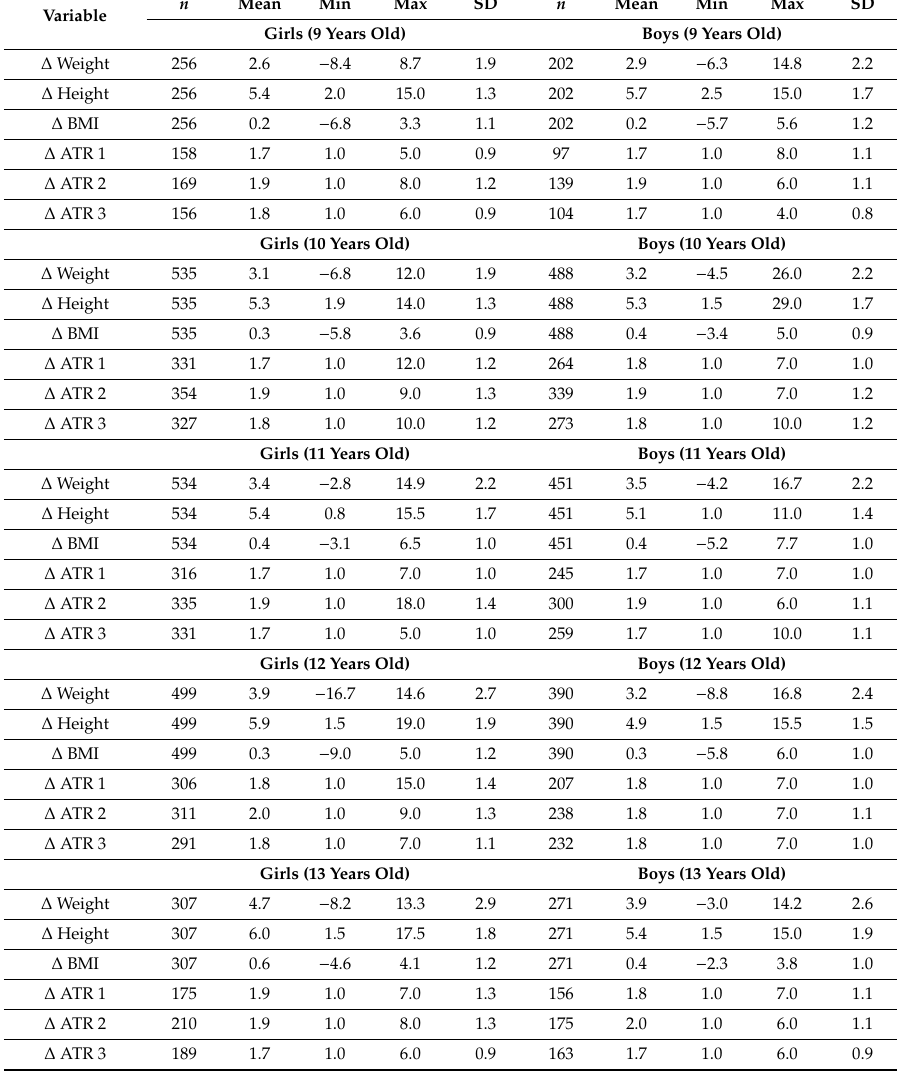
Table 1. Basic characteristics of participants ( n = 3933) presented in annual increases described as the mean, minimum, maximum and standard deviation.